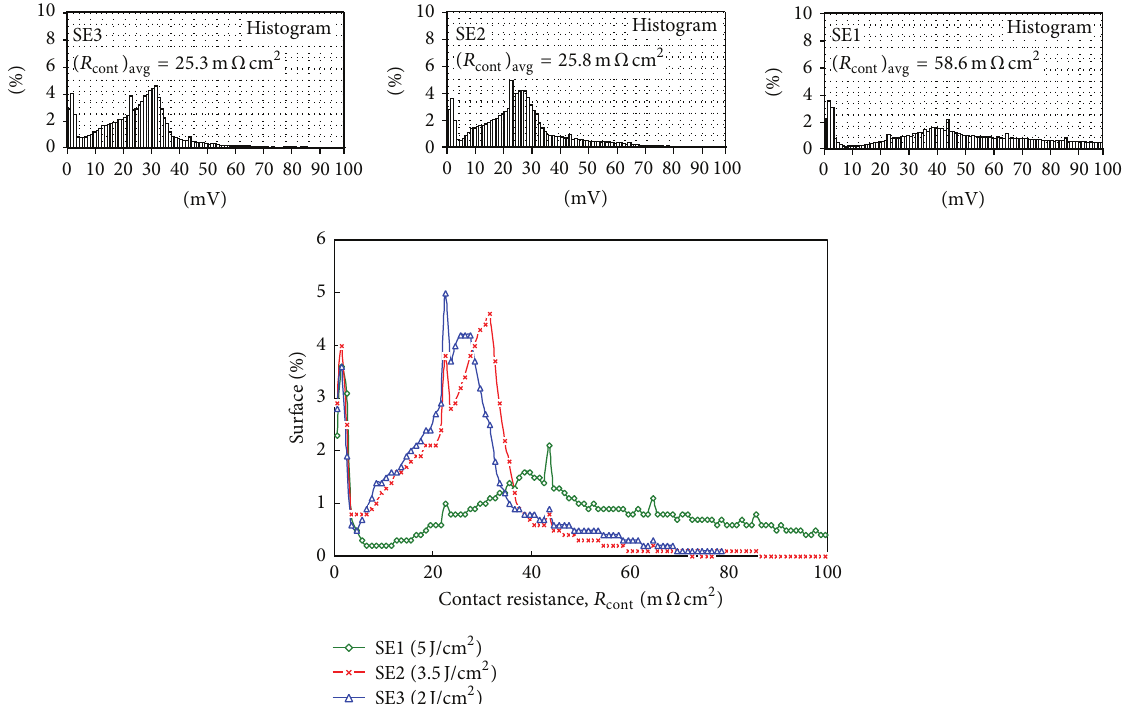
Figure 6: Comparison of distribution profiles of LBIC-contact resistances (in m Ω -cm 2 ) for SE mc-Si solar cells with different laser fluences. The top inserts are real photos measured for average values of contact resistance, (𝑅